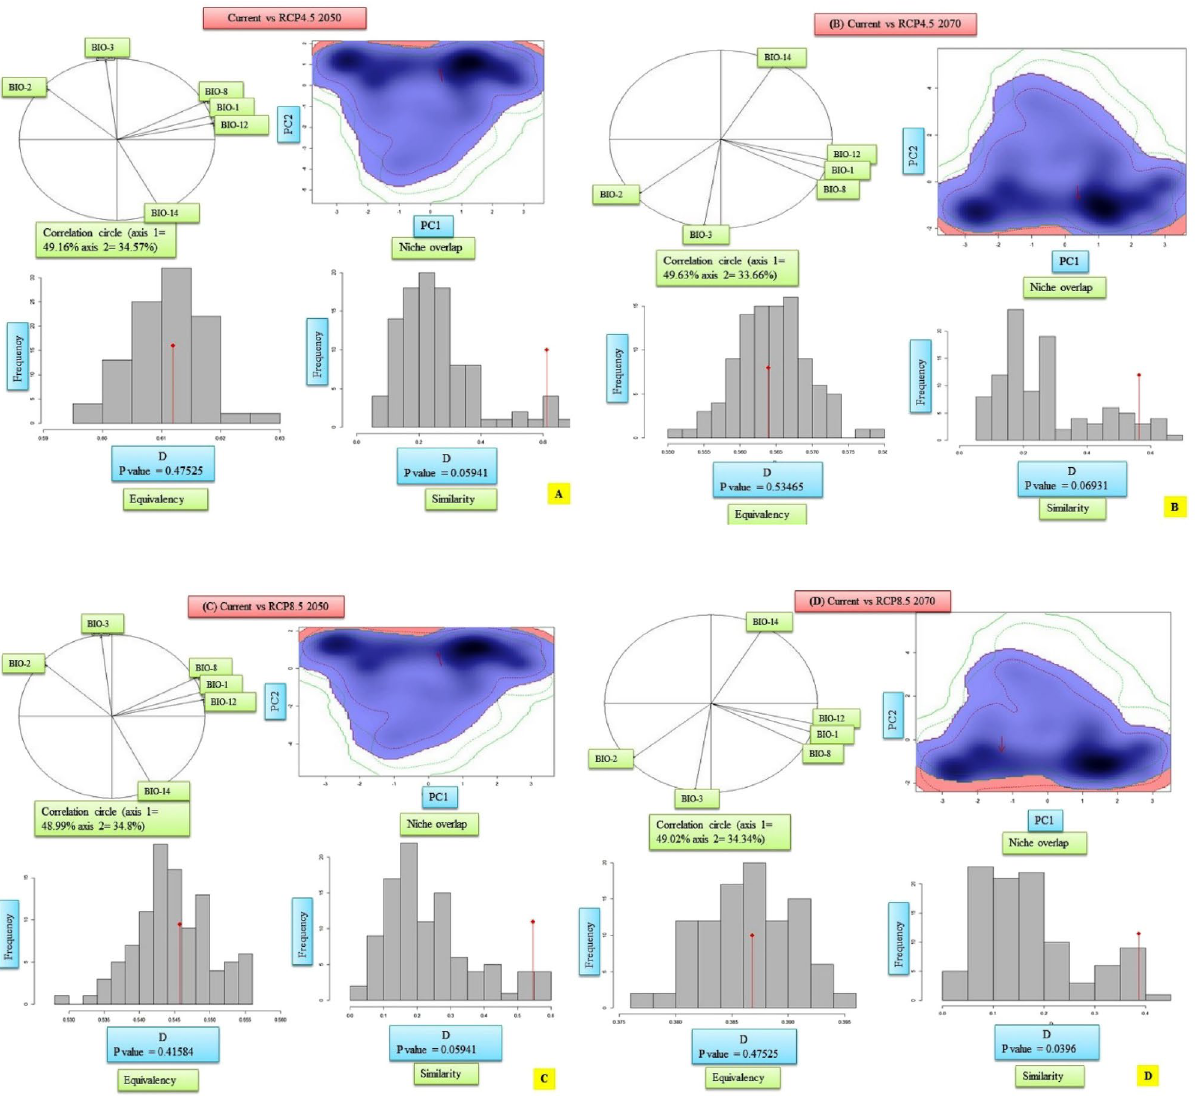
Figure 8. ( A – D ) Current and future climatic niches of Dactylorhiza hatageria . The correlation circle represents contribution of bioclimatic variables to the first two components main of the PCA-env analyses and the percentage of variation explained by each axis. The blue and red shadings represent density of species occurrence under current and future climatic scenarios. The bar plots represent the results of niche equivalency and similarity tests. The red arrow represents the shift in the climatic niche between current and future climatic conditions.